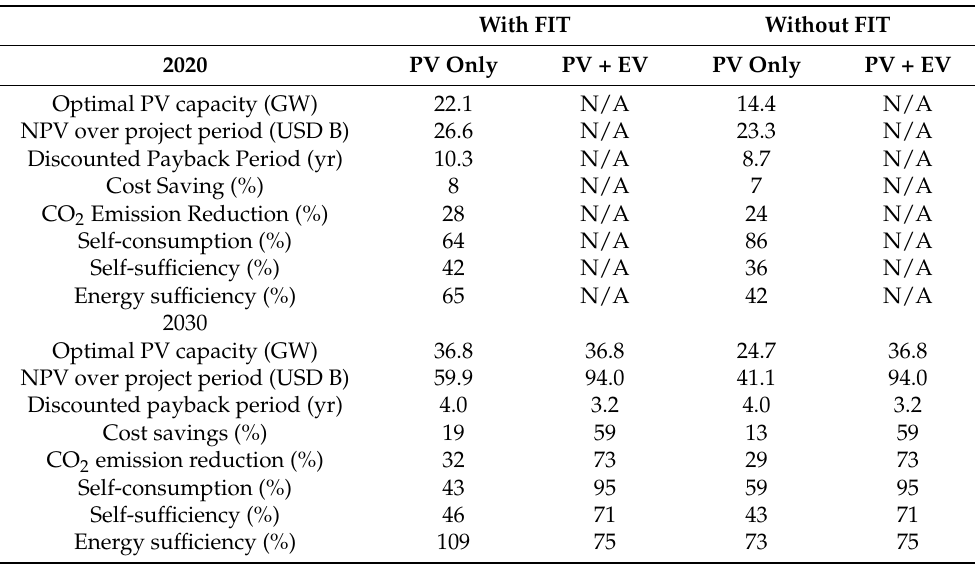
Table 5. Results of the analyses for “PV only” and “PV + EV” in 2020 and 2030 with FITs and without FITs. USD 1B is equal to USD 1,000,000,000. N/A represents no analyses performed. With